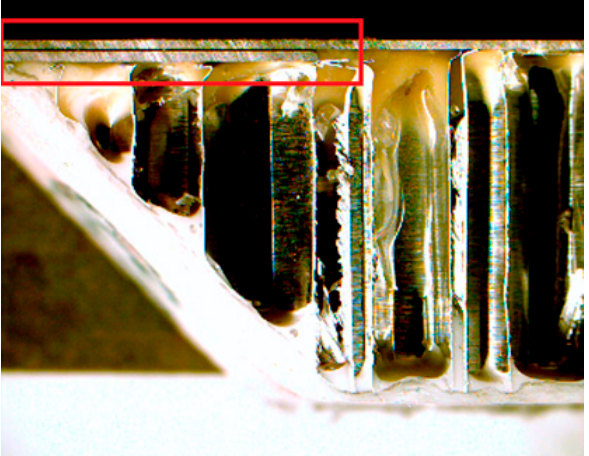
Figure 8. Second layer of aluminum identified under top face sheet near top of damage region close to panel flange.